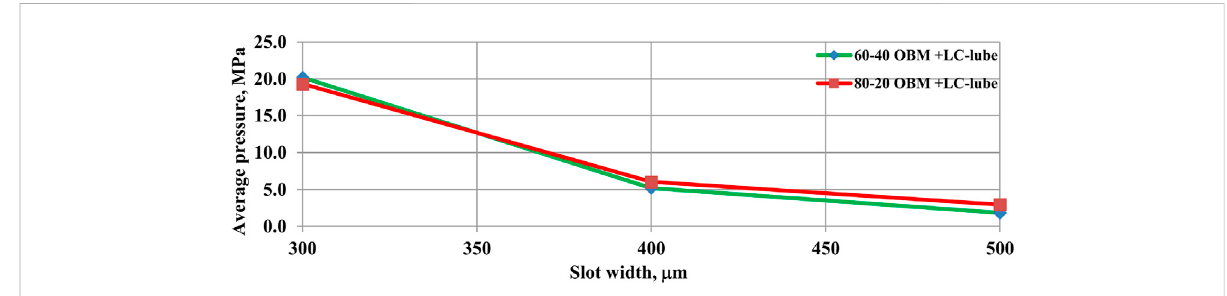
FIGURE 10 Comparisons of 8.48-ppb LC-LUBE-treated 80/20 and 60/40 OBM systems.